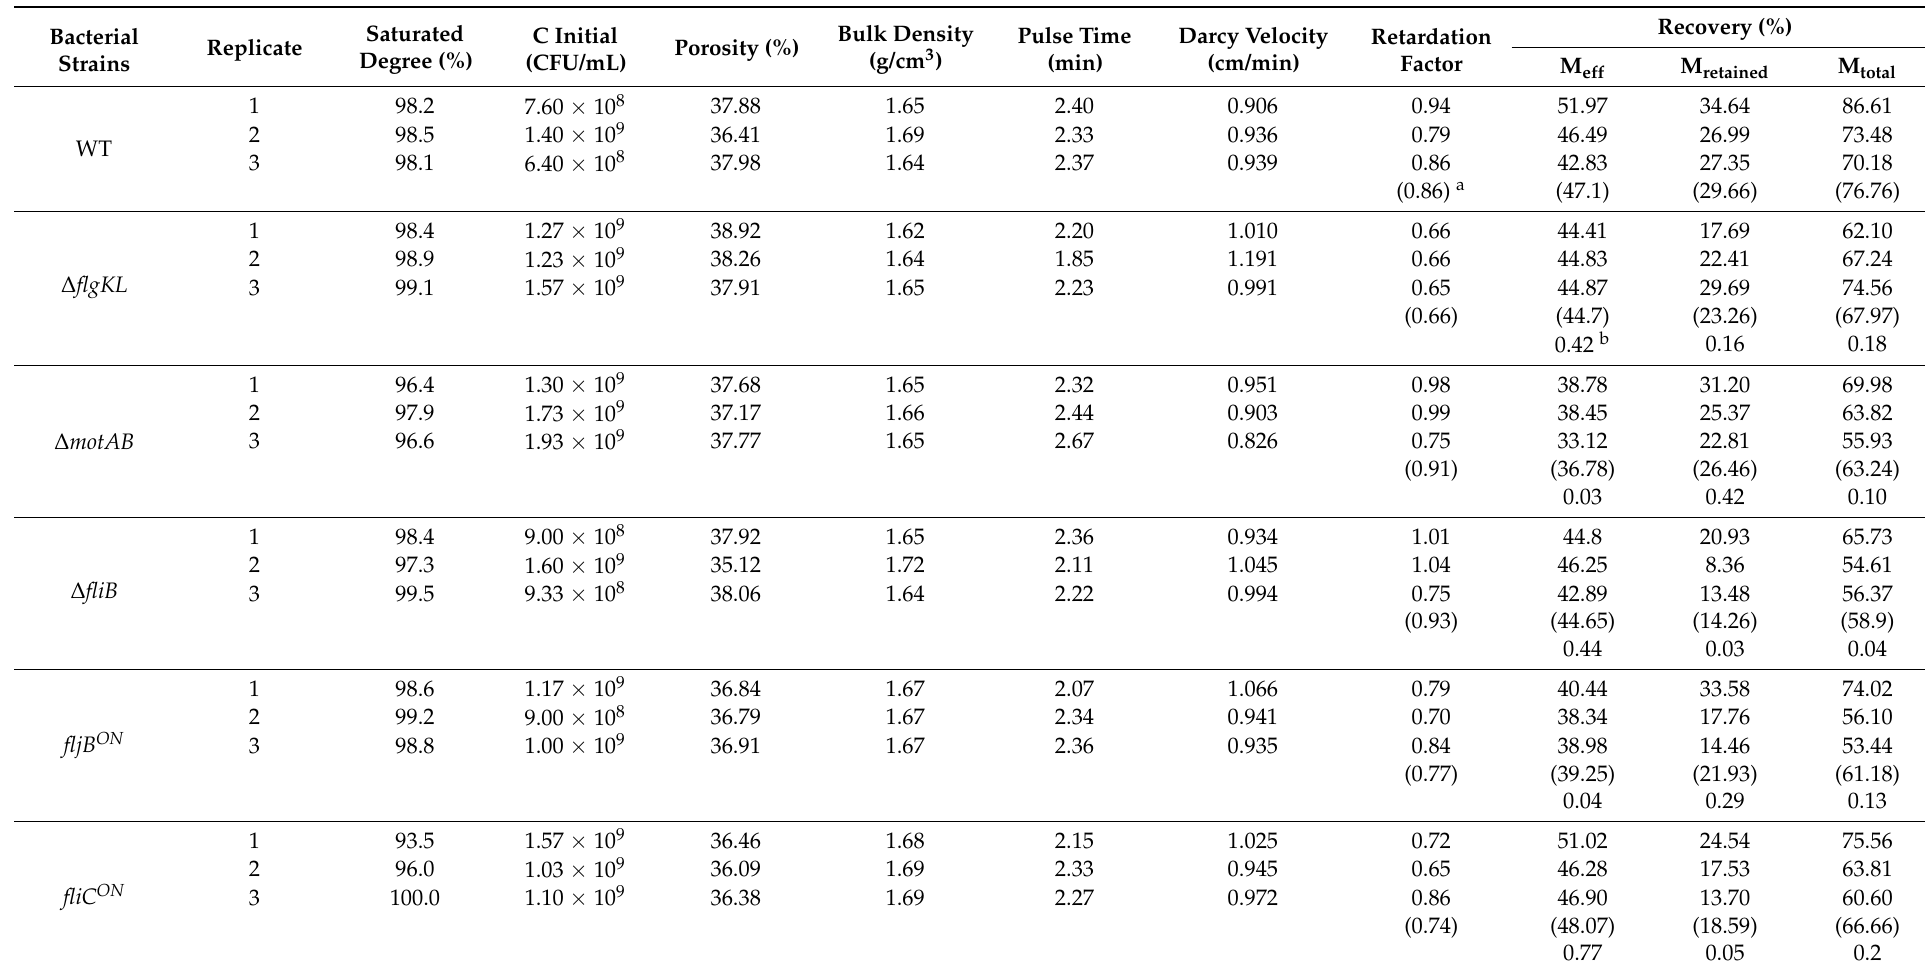
Table 2. Experimental conditions and mass balance information of S. Typhimurium transport experiments under saturated